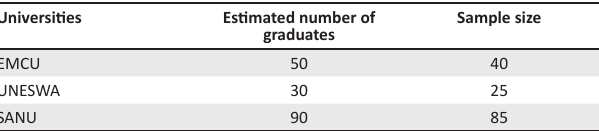
TABLE 1: Sample distribution